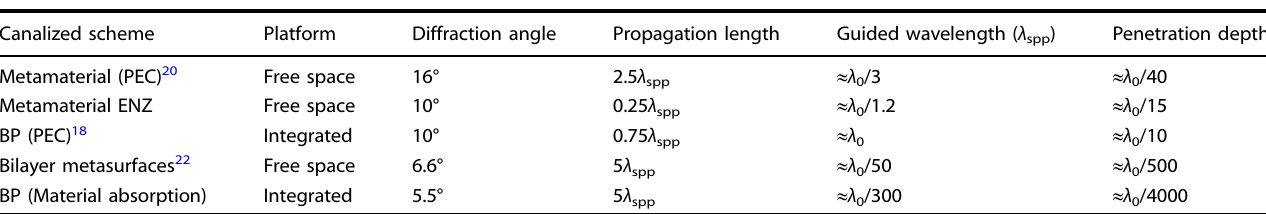
Table 1. Performance comparison of various canalization platforms.